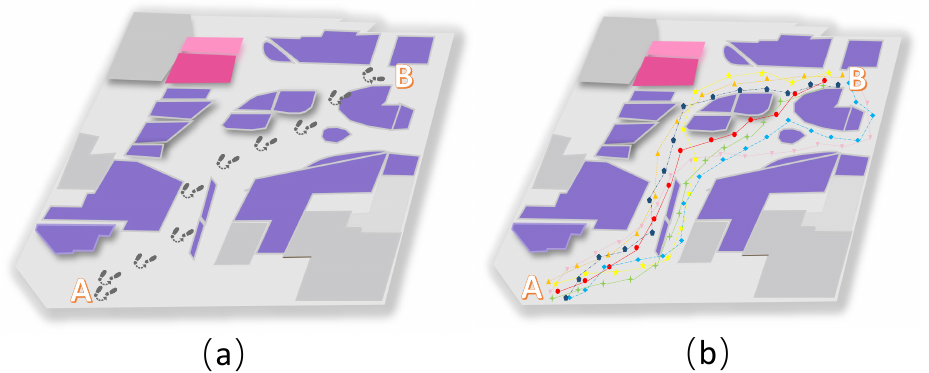
（ a ） （ b ） Figure 7. The graph is a complementary graph of the dataset using machine learning. ( a ) represents the actual trajectory of a person. ( b ) denotes the (partial) dataset after machine learning, and each colored line in the figure represents a group of trajectory data.